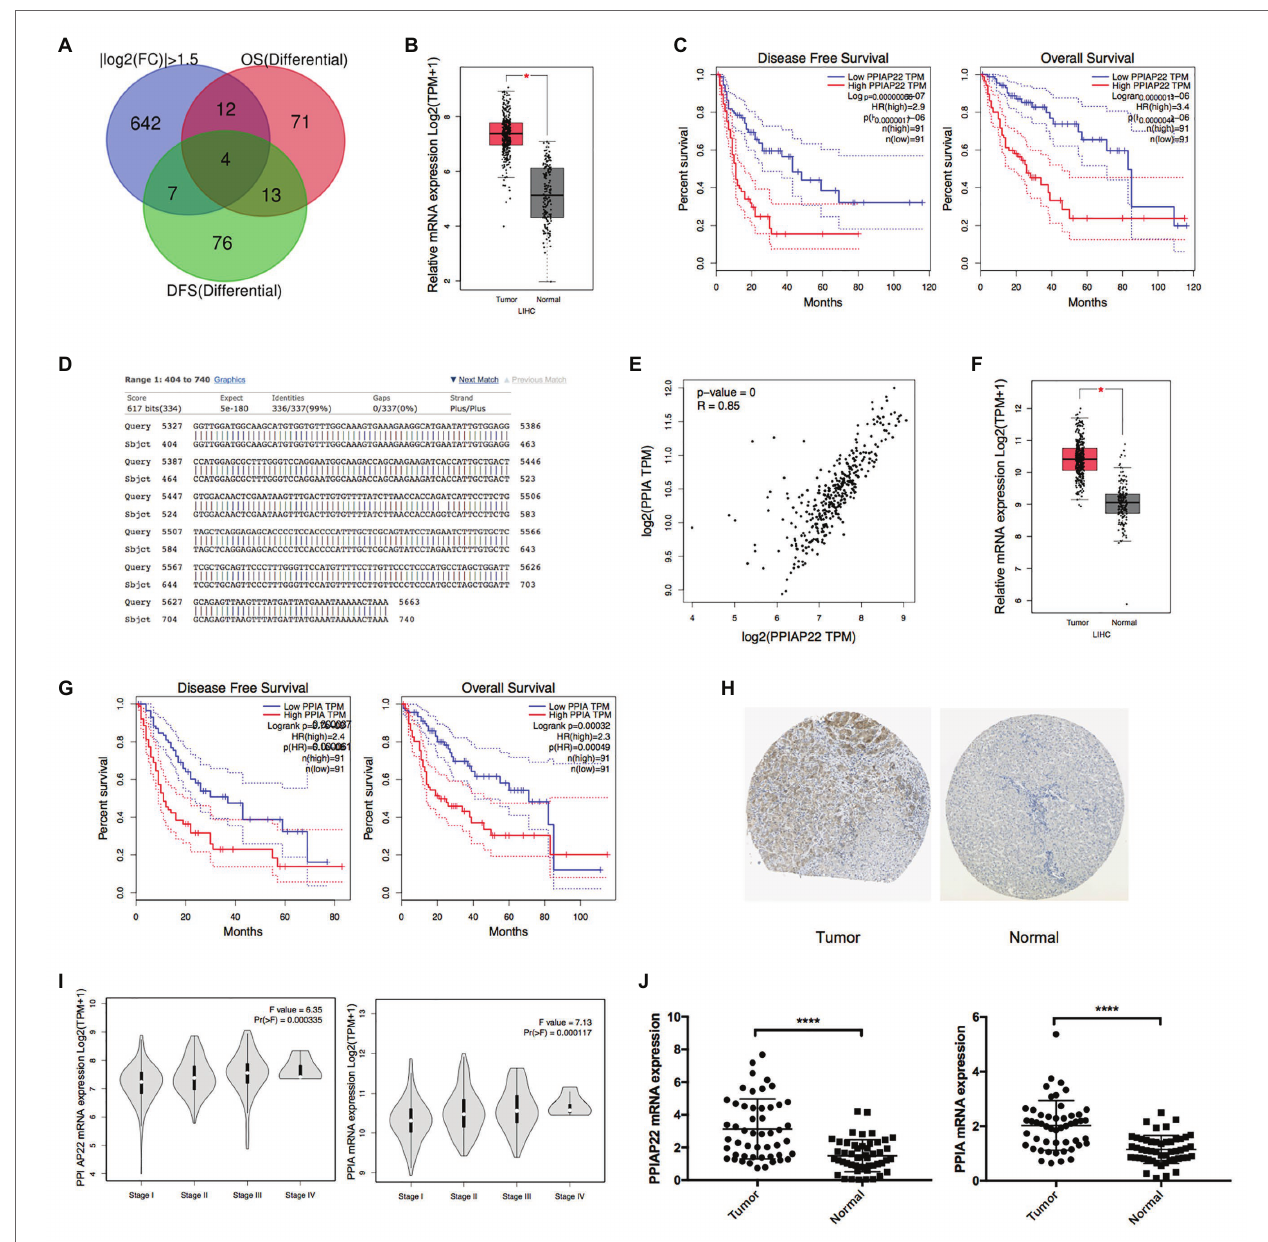
FIGURE 1 | Upregulated peptidylprolyl isomerase A pseudogene 22 (PPIAP22) and peptidylprolyl isomerase A (PPIA) are significantly predicted poor prognosis of hepatocellular carcinoma (HCC) patients. (A) Bioinformatics analysis of differential genes with a log2 fold change ≥ |1.5|, p < 0.05, and with significant associations with overall survival (OS) and disease-fee survival (DFS) of HCC patients using Gene Expression Profiling Interactive Analysis (GEPIA). (B) PPIAP22 was upregulated in tumor tissues with HCC compared with normal tissues, analyzed with GEPIA using the Cancer Genome Atlas (TCGA) and GTEx databases. (C) Prognostic values of PPIAP22 in HCC analyzed with GEPIA. The dotted lines represent the 95% CI. (D) Sequence similarity between PPIAP22 and its parental gene PPIA. (E) Correlation analysis between PPIAP22 and PPIA in HCC using GEPIA. (F) PPIA was upregulated in tumor tissues with HCC compared with normal tissues, analyzed with GEPIA. (G) Prognostic values of PPIA in HCC analyzed with GEPIA using TCGA and GTEx databases. The dotted lines represent the 95% CI. (H) The expression of PPIA was analyzed using immunohistochemistry from the Human Protein Atlas database. (I) The correlation between PPIAP22 or PPIA mRNA expression and the clinic stage of HCC patients were analyzed with GEPIA. (J) PPIAP22 and PPIA mRNA expression levels were higher in tumor tissues than in normal (50 pairs, p < 0.0001). PPIAP22, peptidylprolyl isomerase A pseudogene 22; PPIA, peptidylprolyl isomerase A; and HCC, hepatocellular carcinoma. * p < 0.05; **** p < 0.0001,